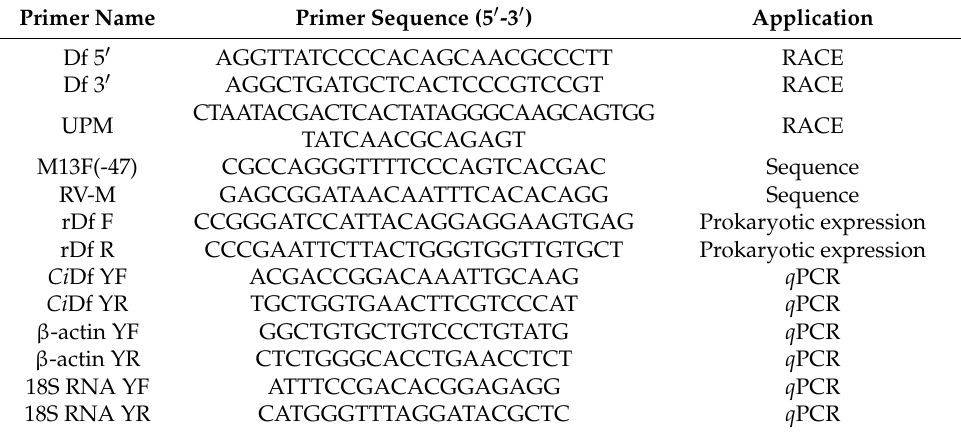
Table 1. Information regarding primers used in this